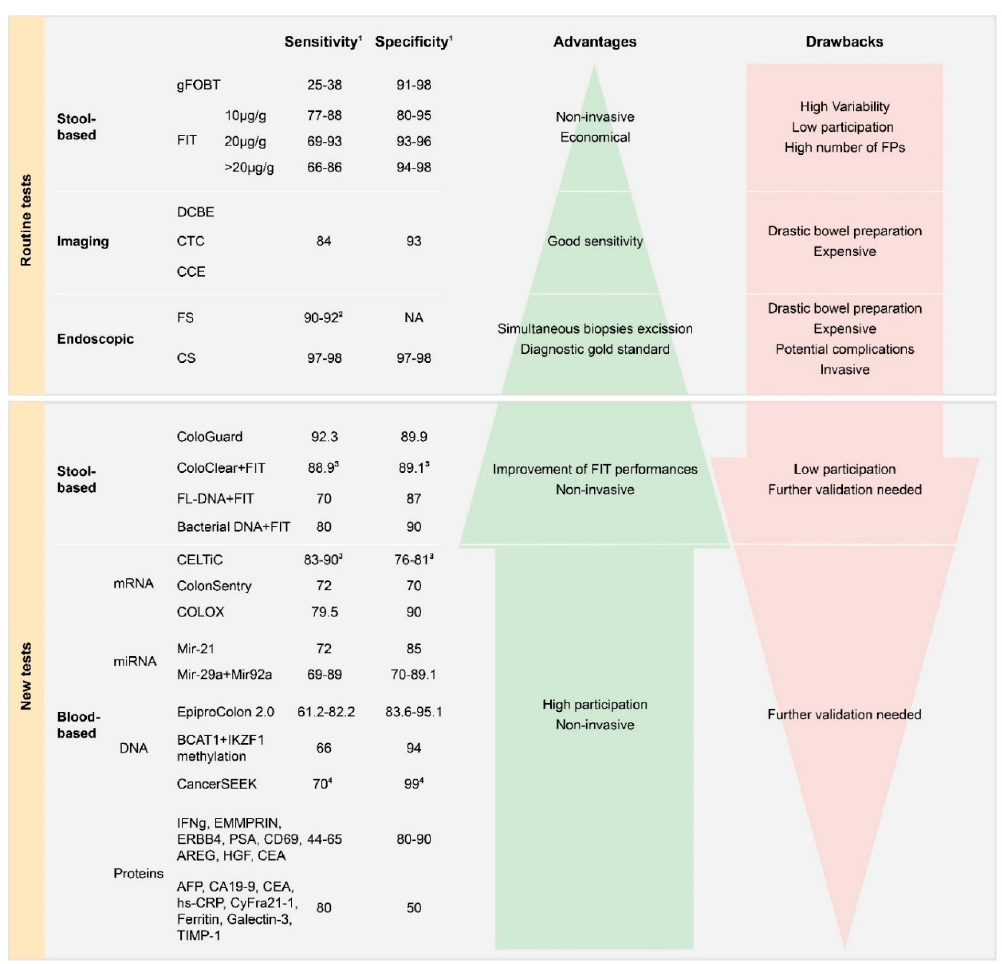
Figure 3. Routine and new tests used or proposed for colorectal cancer screening. Guaiac fecal occult blood test (gFOBT), fecal immunochemical test (FIT), double-contrast barium enema (DCBE), computed tomographic colonography (CTC), colon capsule endoscopy (CCE), colonoscopy (CS), flexible sigmoidoscopy (FS), fluorescent long DNA (FL-DNA), not available (NA), false positive (FP). 1 The reported percentages of sensitivity and specificity refer to colorectal cancer. 2 Refers only to distal colorectal cancer. 3 Refers to advanced neoplasia. 4 Refers to the average value among 8 cancer types.